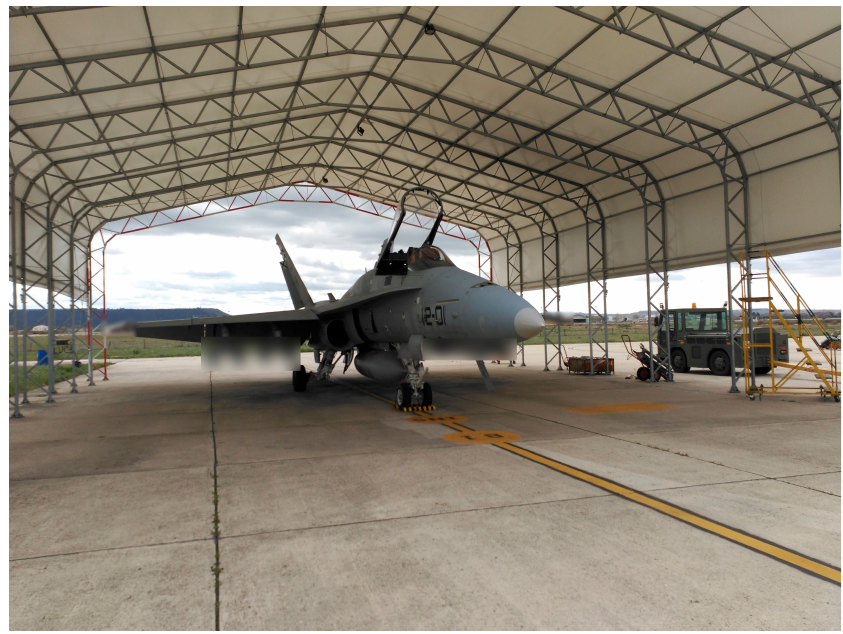
Figure 2. F-18 in the CLAEX platform ready to perform a Flutter Flight Test sortie. Stores configura- tion has been blurred due to